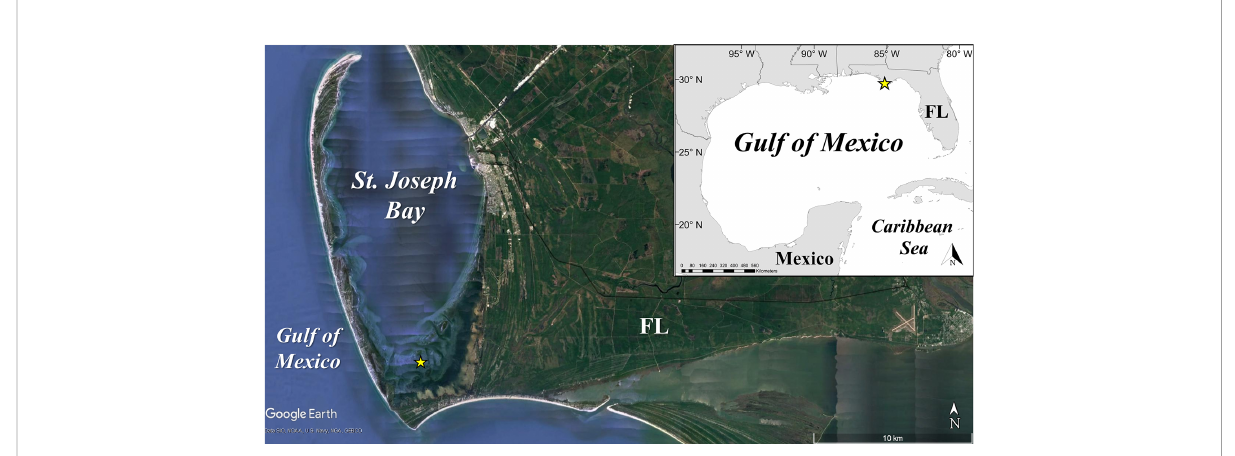
FIGURE 1 Study area in St. Joseph Bay, Florida in the northeastern Gulf of Mexico. Experimental array (yellow star) is located in the southern turtlegrass beds of St. Joseph